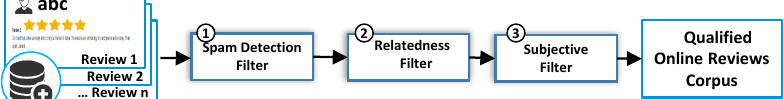
Figure 2. Abstract view of user review quality checking process.